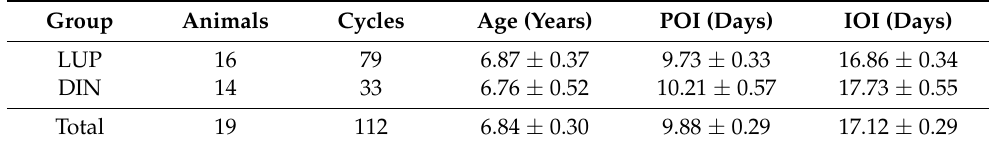
Table 1. Prostaglandin–ovulation interval (POI) and interovulatory interval (IOI) in cycles of jennies treated with luprostiol (LUP) or dinoprost tromethamine (DIN). Group Animals Cycles Age (Years) POI (Days) IOI (Days) LUP